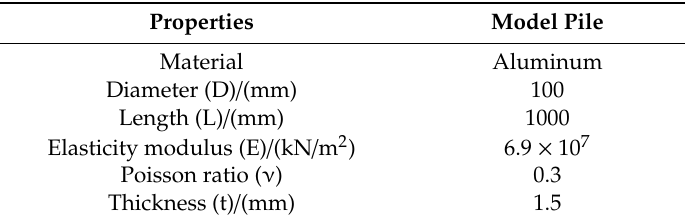
Table 2. Properties of model open-ended pile.